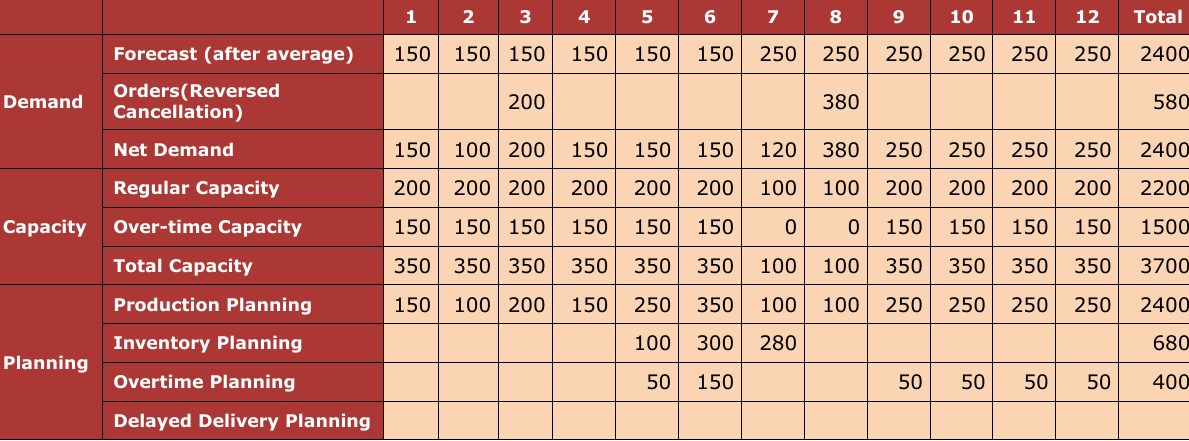
Table 2. Optimization Process of Considering On-time Delivery and Product